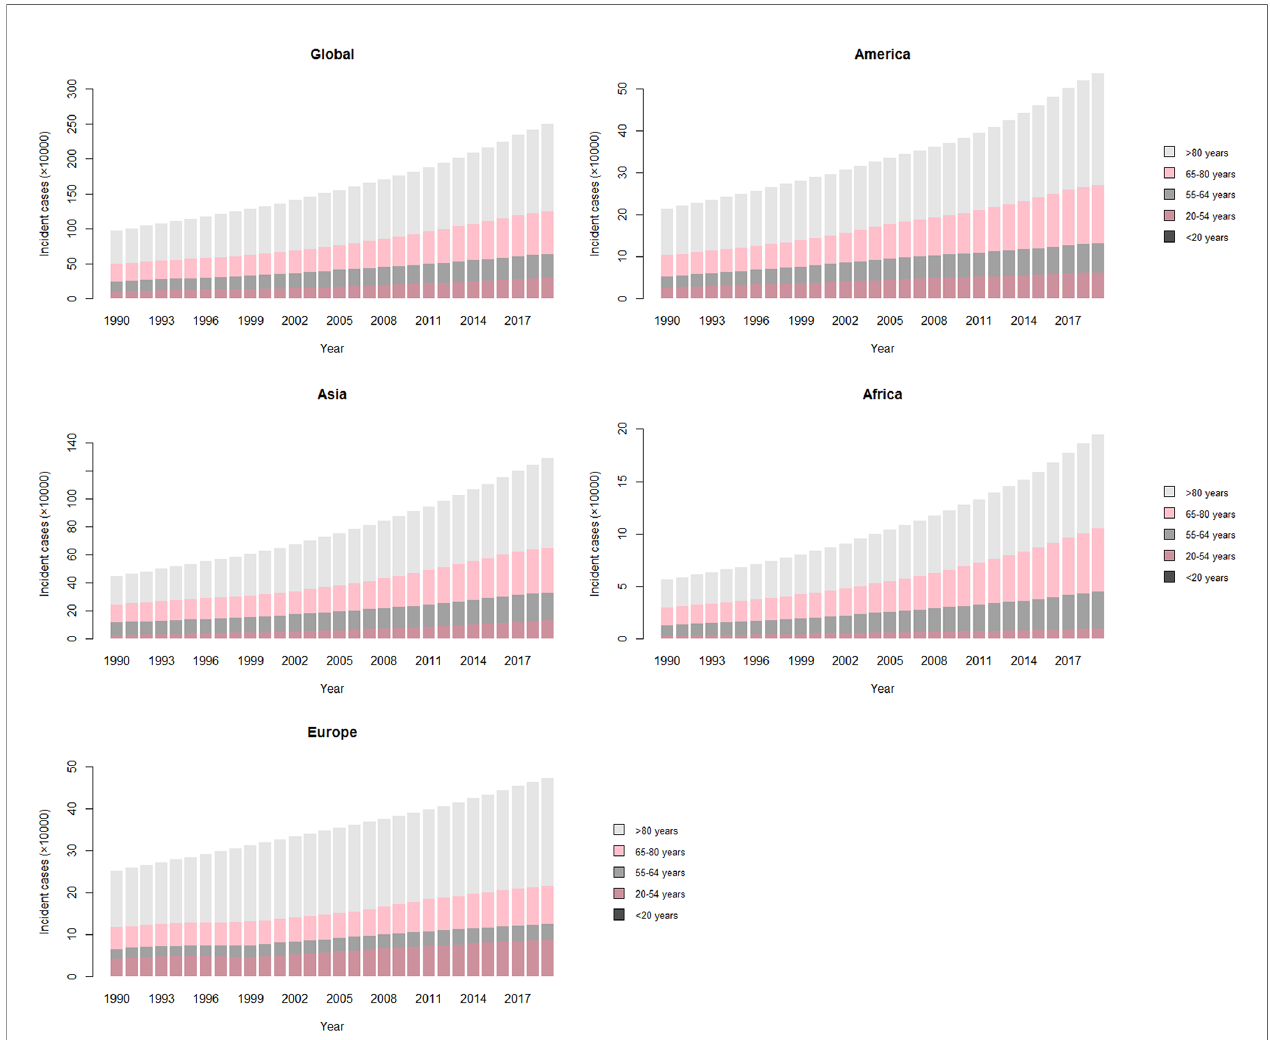
FIGURE 2 | The number of type 2 diabetes – related CKD incident cases over 30 years. The vertical axis is the incident cases of type 2 diabetes – related CKD in four world regions (America, Asia, Africa, and Europe). The horizontal axis represents 30 years (1990 – 2019). Each column is the total number of incident cases